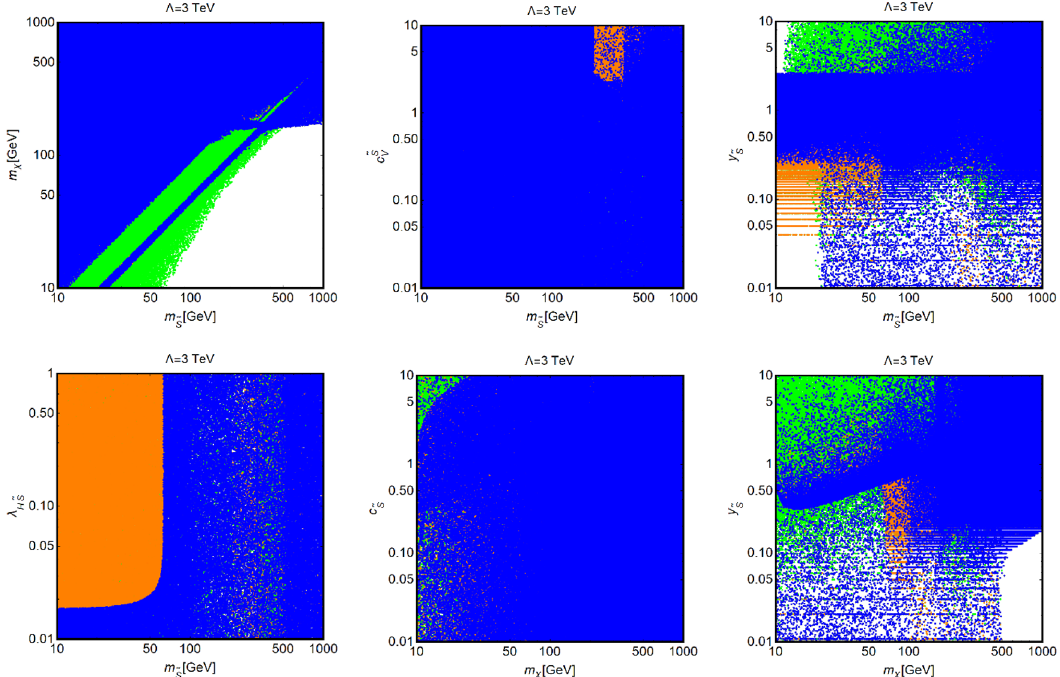
Figure 16 . Results of the parameter scan for the pseudoscalar e DMeft setup in various planes, analogous to the scalar case presented in (cid:12)gures 7 and 8, see text for details. Contrary to the case of the scalar mediator we have shown the ( m (cid:31) ; c ~ latter is not impacted by the constraints considered in our